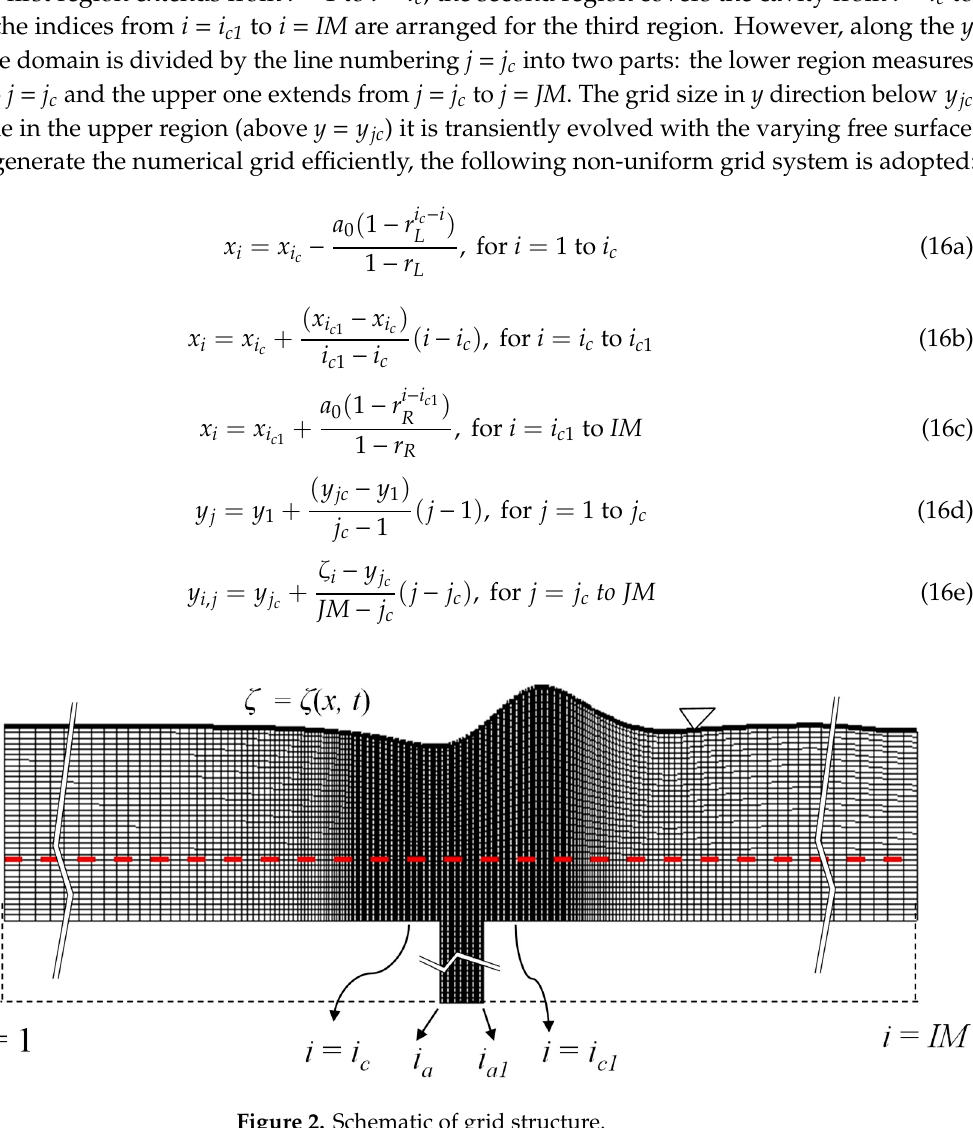
Figure 2. Schematic of grid structure.